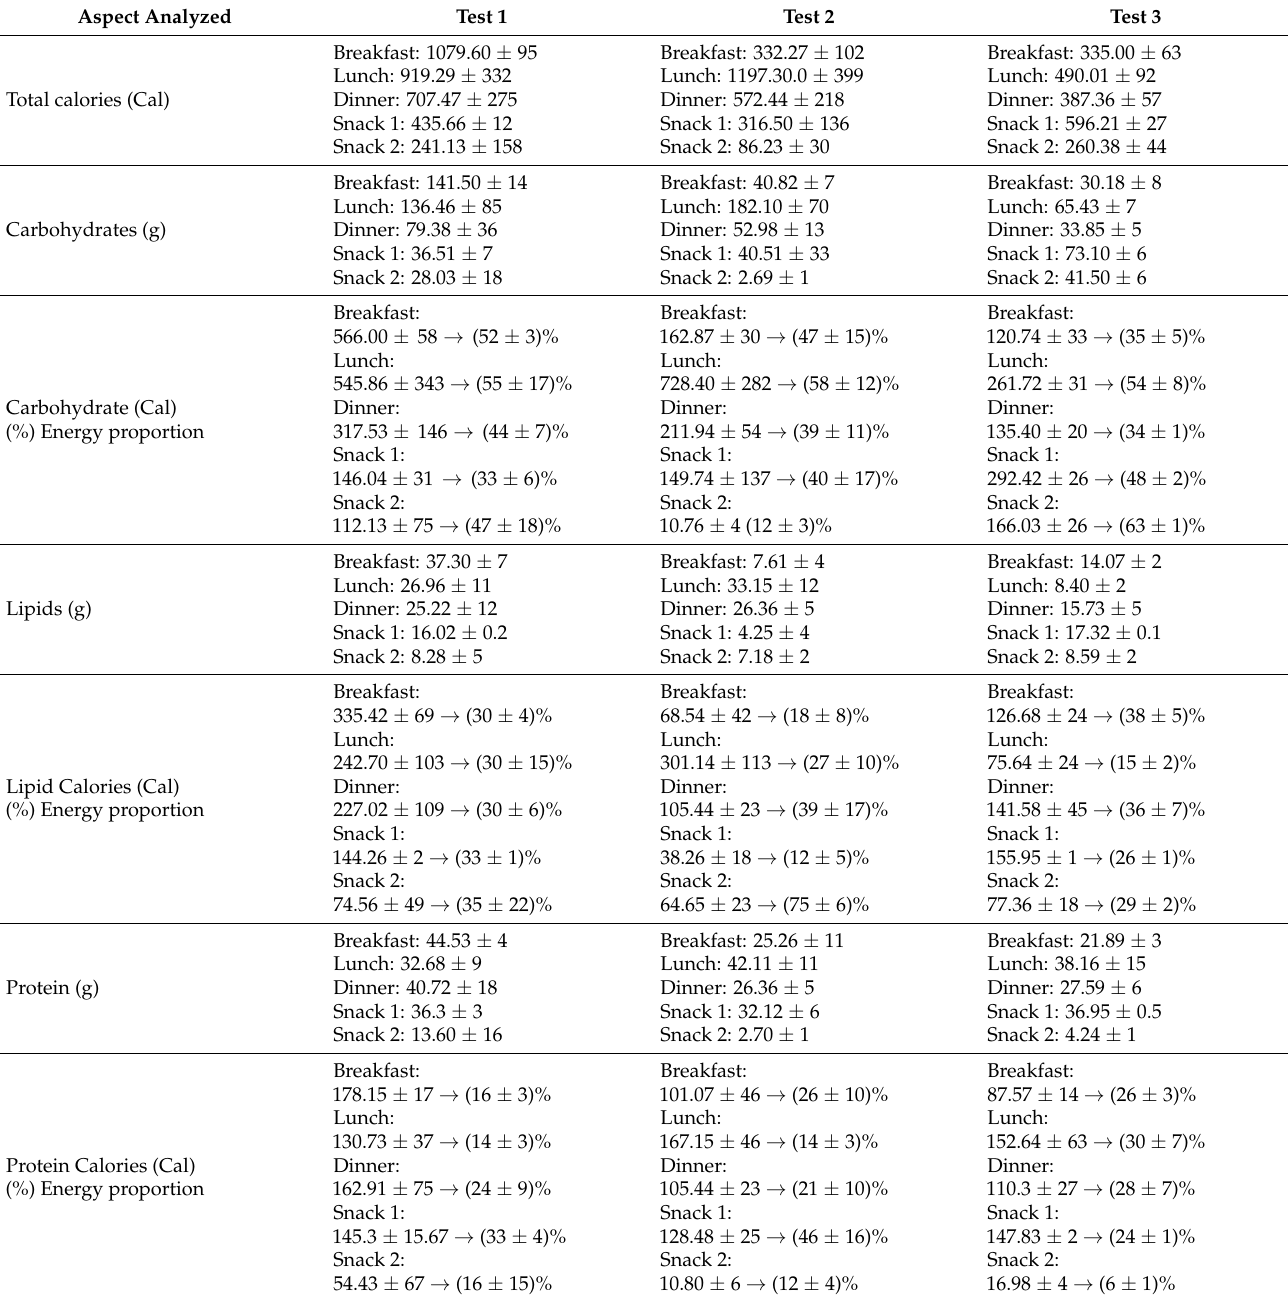
Table 3. Proportions of macronutrients